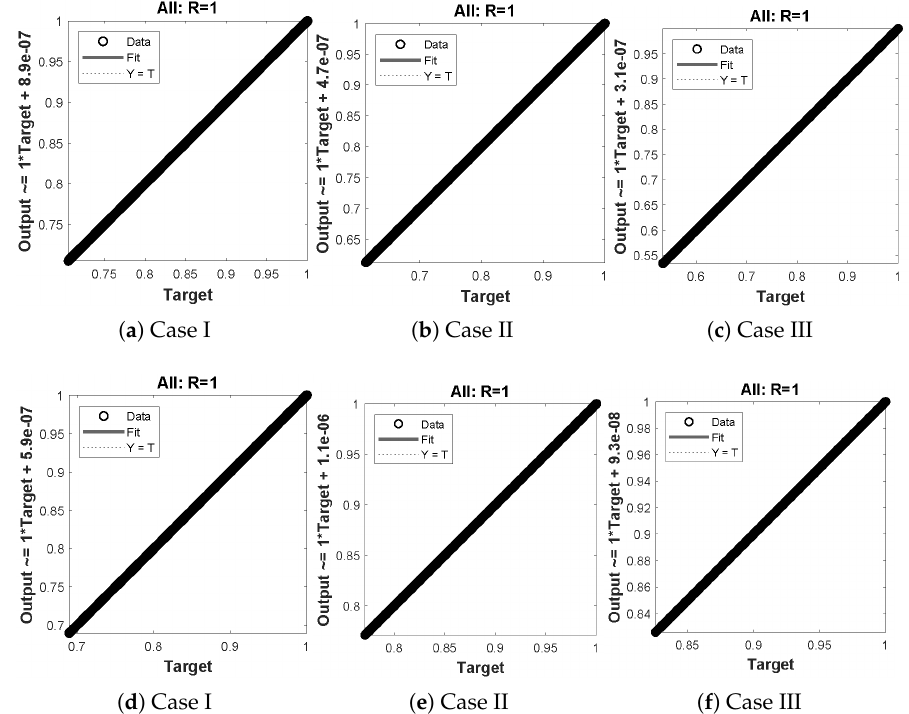
Figure 13. ( a – f ) shows the regressionanalysis for dimensionless concentration of substrate of micro- disk biosensor model.